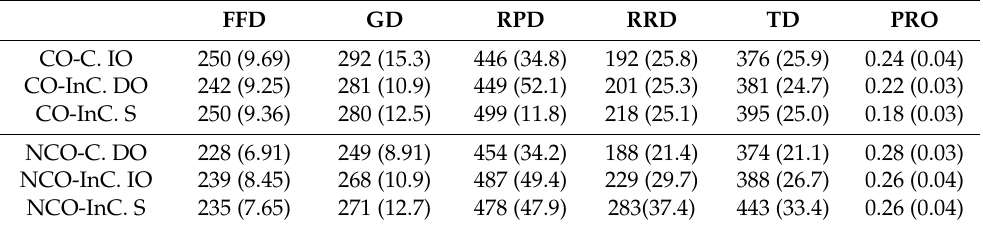
Table 3. Mean Values for the Six Conditions (in msec. for durations), with Standard Errors in Parentheses, for the Six Eye-tracking Measures for